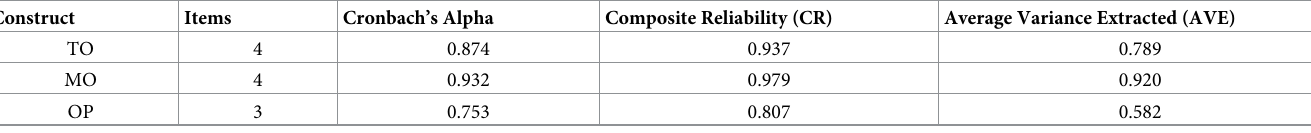
Table 3. Results of confirmatory factor